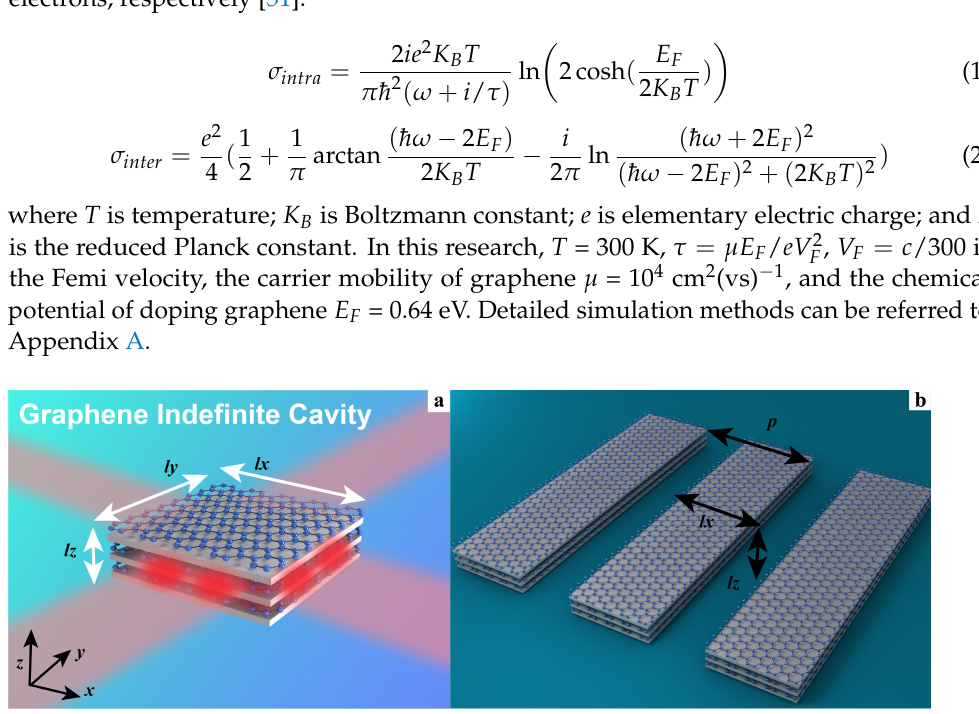
Figure 1. Schematic of the graphene indefinite nanocavity.( a ). Perspective view of the a nanocavity made of mulilayered graphene-silicon HMM with indefinite permittivity. ( b ). 2D graphene indefinite cavity